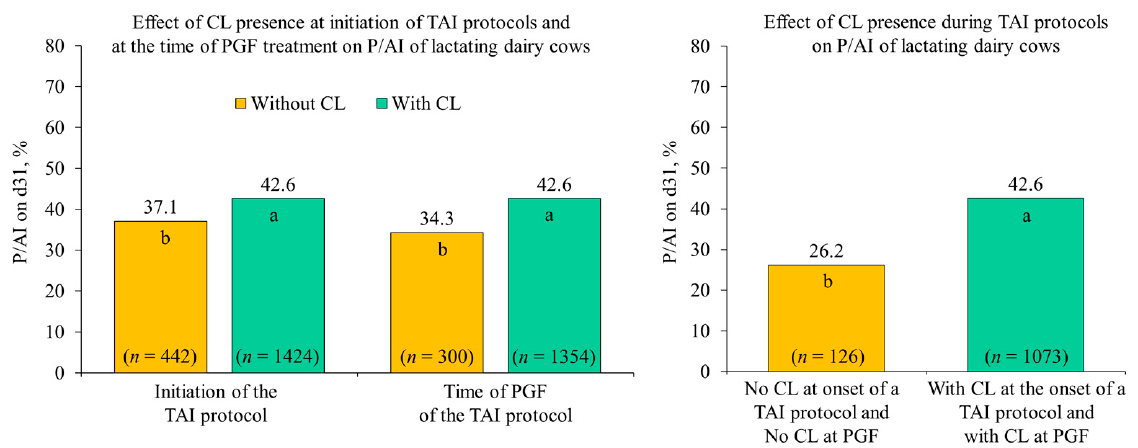
Figure 2. Effect of the presence of corpus luteum (CL) during timed artificial inseminations (TAI) protocols on pregnancy per AI (P/AI) of lactating dairy cows. a,b Different letters represent differences ( p < 0.05). Prostaglandin F2 α (PGF). Data from 3 experiments from our lab in which cows were submitted to TAI protocols initiated with progesterone implant and estradiol benzoate, GnRH, or both [30].